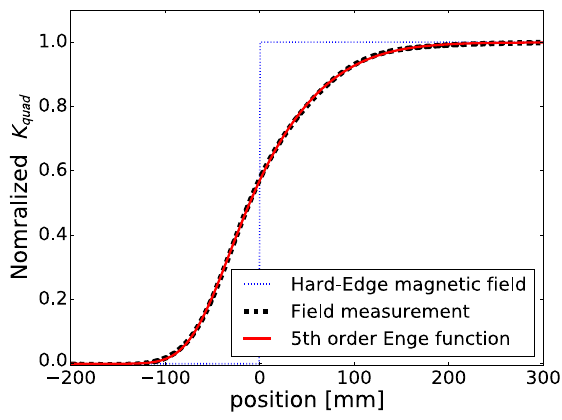
FIG. 3. Fringe field as simulated [26] and modeled for the MQXF quadrupoles with an aperture of 150 mm. In black is the simulated field of the magnet, and in red is the modeled field using the fifth order Enge function. The modeled fringe field agrees very well with the simulated data and validates the used order of the Enge function.